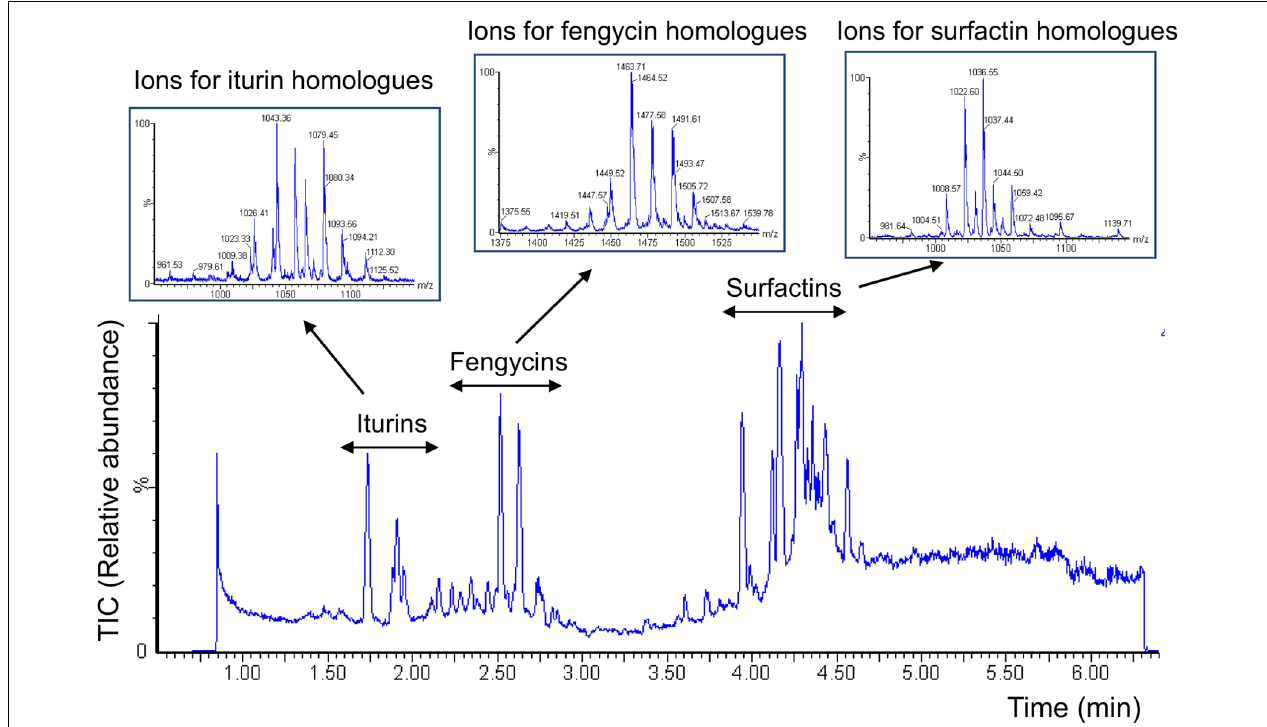
FIGURE 2 | Diversity of lipopeptides secreted by strain S499 upon growth in maize exudates. UPLC-ESI-MS chromatogram illustrates the variety of lipopeptides produced by B. amyloliquefaciens S499 upon growth in exudates collected from maize seedling as sole nutritional source (MRE medium). Extracted ions typical for surfactins, iturins, and fengycins and representing the various homologes within each lipopeptide family are detailed in